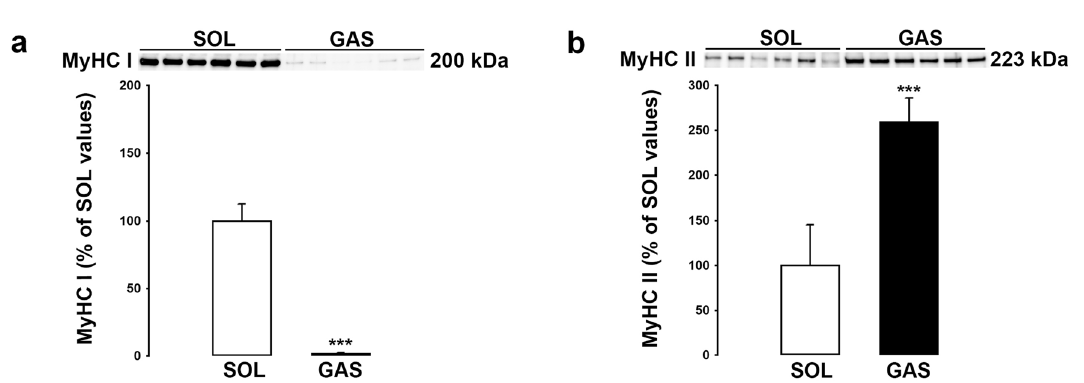
Figure 6. Expressions of slow-type (MyHC I) and fast-type fibers (MyHC II) in soleus (SOL) and gastrocnemius (GAS) muscles. Expression of MyHC I (200 kDa, a ) and MyHC II (223 kDa, b ) were determined in SOL and GAS muscles of control rats (n = 6 per group) by Western blotting method. Results are expressed as percentage of SOL muscle values (means ± SD). ***p < 0.001 versus SOL muscle. Representative immunoblots of each marker are shown above bar